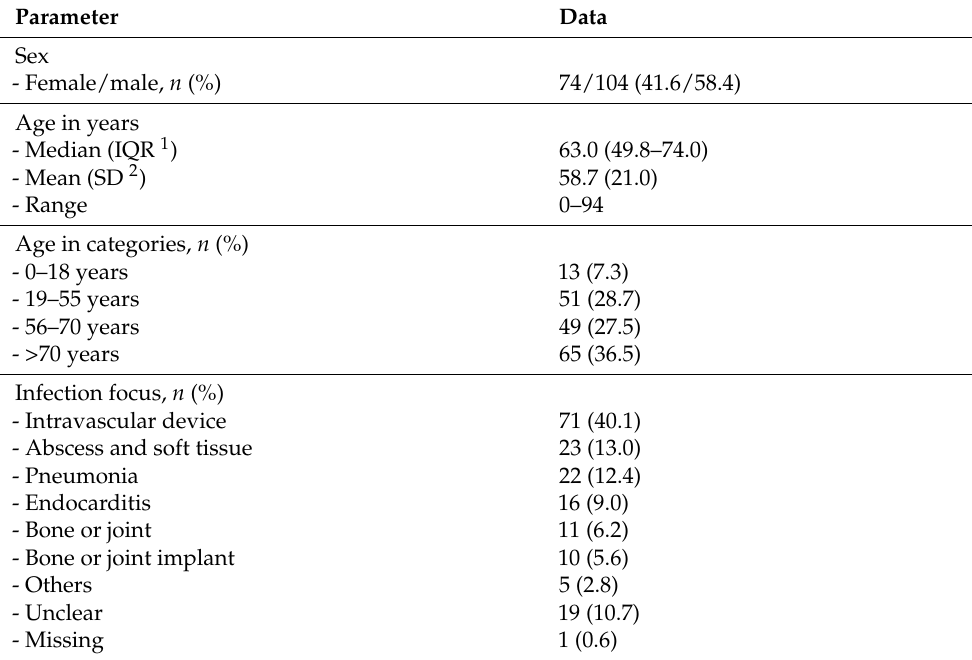
Table 2. Patient characteristics and clinical